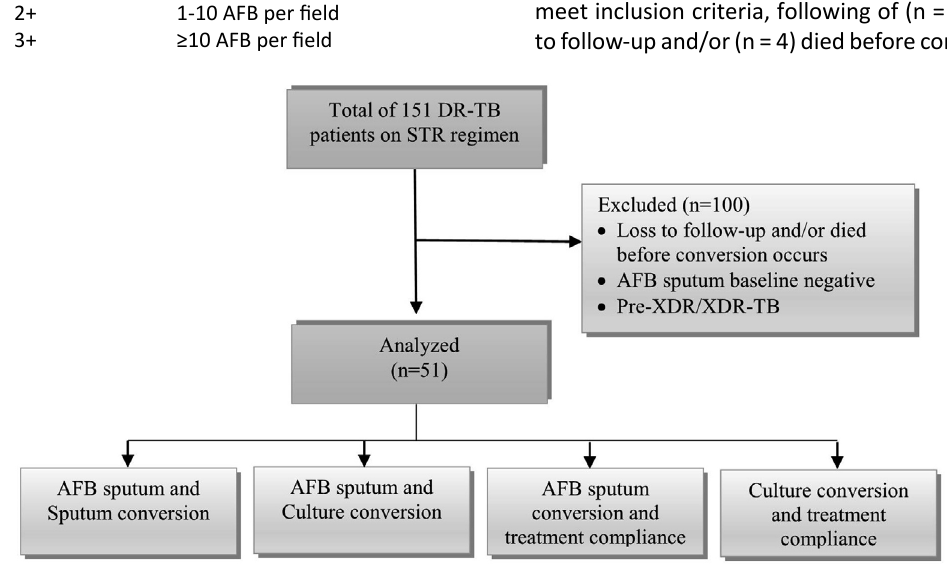
Fig. 1. Study flow diagram. A total 51 DR-TB patients on STR regimen comprised the study population after excluding